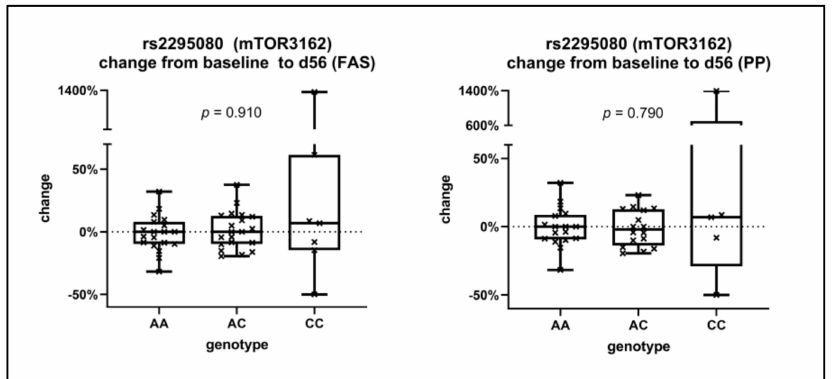
Figure 3. Relative change of the size of the target lesion on day 56 compared to baseline, stratified by the genotype of the rs2295080 (mTOR3162) polymorphism. The results are given in the full analysis set (FAS, left) and the per protocol analysis (PP, right). Table 1. Oncological outcome in the FAS (full analysis set), stratified by IMDC risk groups, thrombospondin-2 levels at baseline (C1D1) and C1D15, and the lactate dehydrogenase level at C1D15.